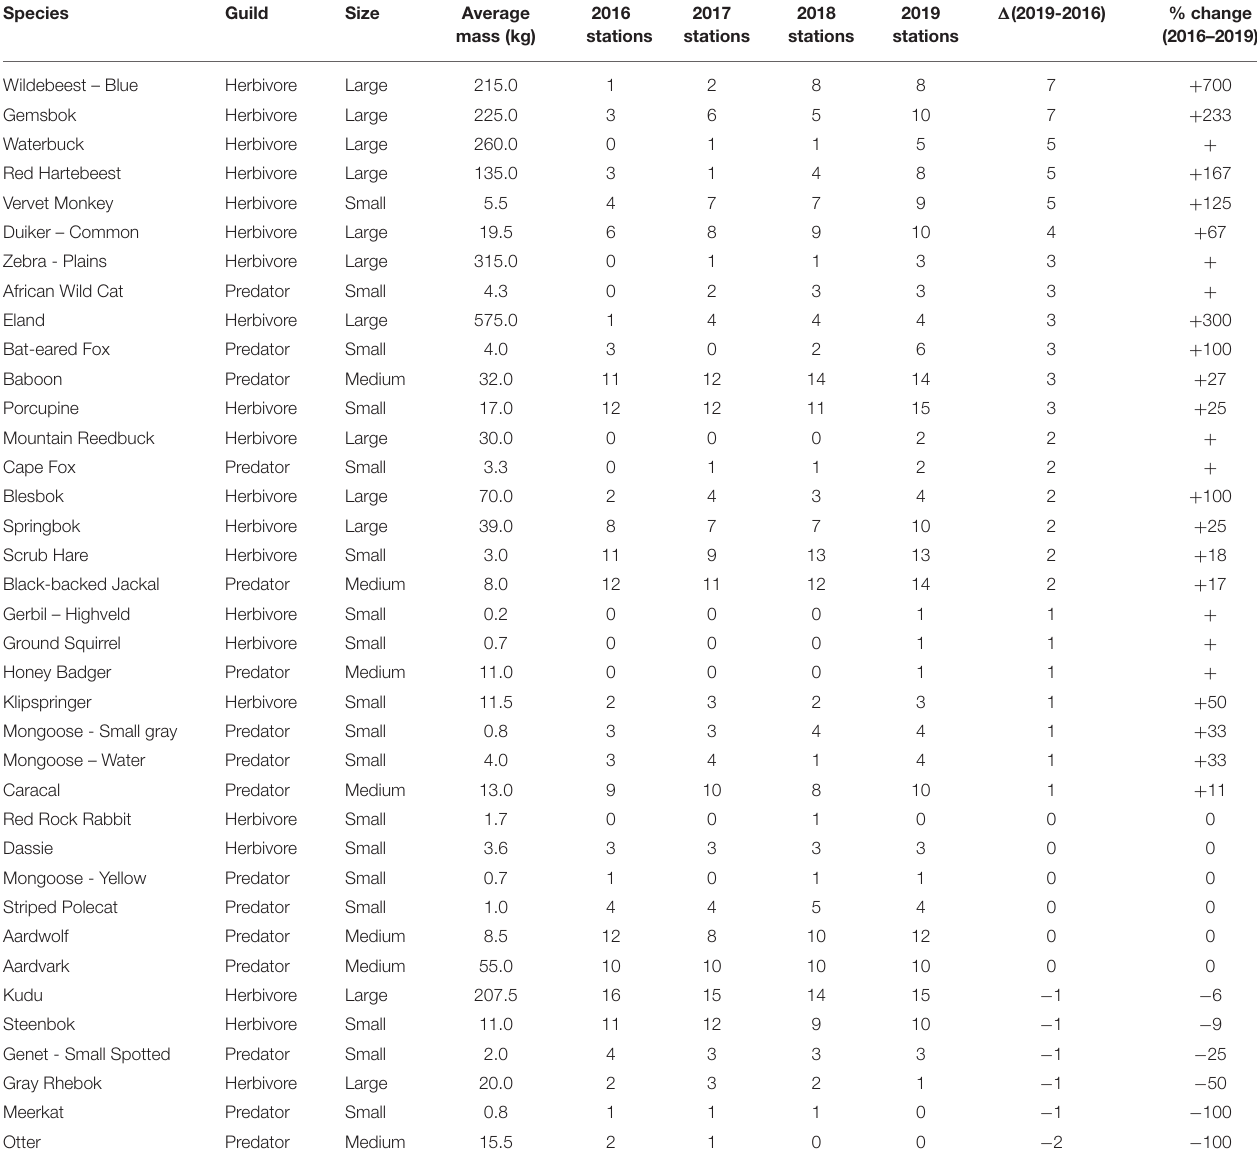
TABLE 2 | Number of cameras at which each species was detected, ordered by absolute ( 1 ) increase and then percentage increase.